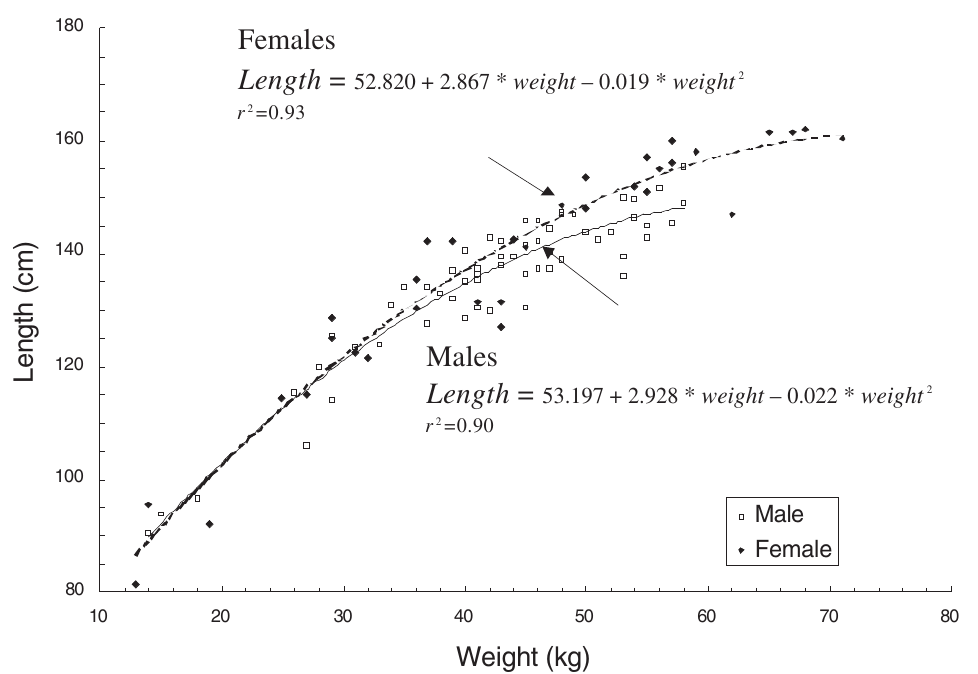
Fig. 3: Length and weight data for male and female harbour por- poises inciden- tally caught in fishing gear in eastern